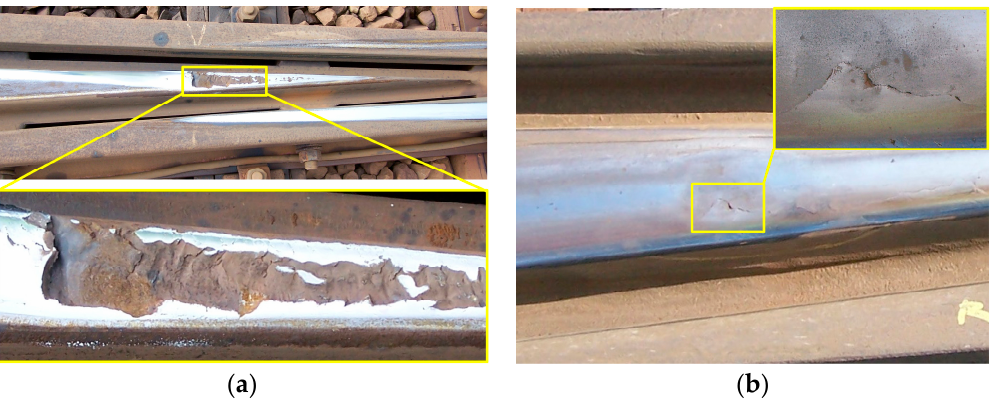
Figure 2. Examples of severe degradation at crossings. ( a ) Shelling: a subsurface fatigue phenomenon associated with high wheel-rail contact stresses; ( b ) squats: a local rail top deformation in the running band.